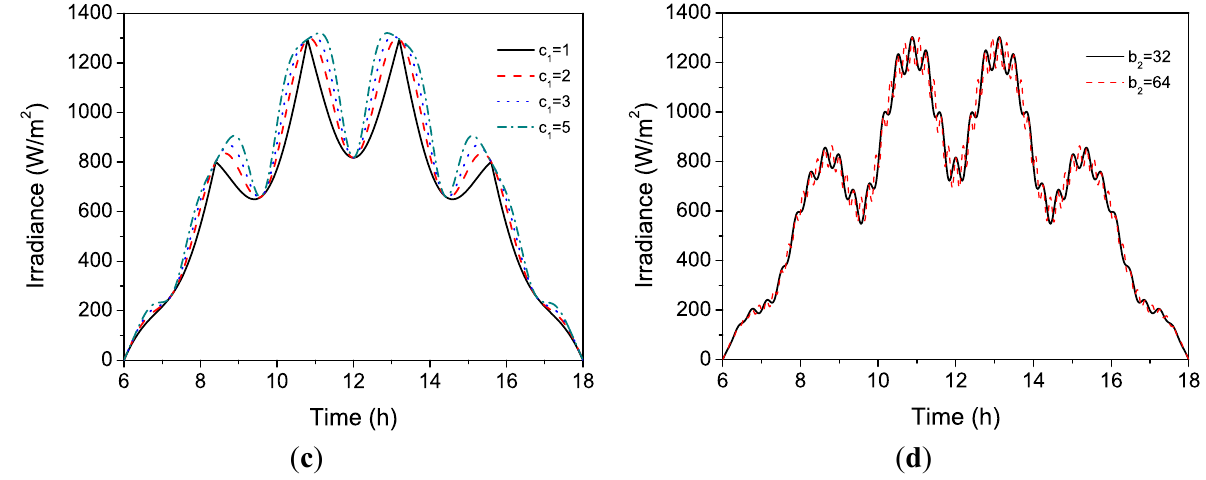
Figure 1. Solar radiation distributions obtained by the proposed model for the different values of the parameters in Equation (4): ( a ) M = 1, b 1 = 5, c 1 = 3, a 2 = 0; ( b ) M = 1, a 1 = 0.3, c 1 = 3, a 2 = 0; ( c ) M = 1, a 1 = 0.3, b 1 = 5, a 2 = 0; ( d ) M = 1, a 1 = 0.3, b 1 = 5, c 1 = 3, a 2 = 0.1, c 2 =